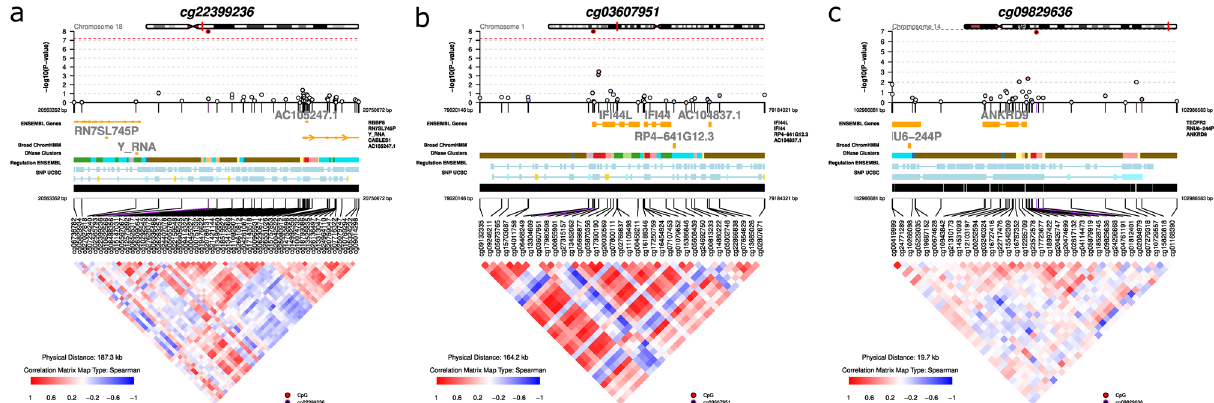
Figure 7. Visualization of the three differentially methylated CpGs identified in the COVID-19 positive versus COVID-19 negative comparison. ( a ) cg22399236 (chr18:20651637) ( b ) cg03607951 (chr1:79085586) in IFI44L ( c ) cg09829636 (chr14:102976856) in ANKRD9 . The correlation map underneath each plot represents pairwise correlations between any two probes (red for high correlation and blue for low correlation). The plot was generated using the coMET R package 71